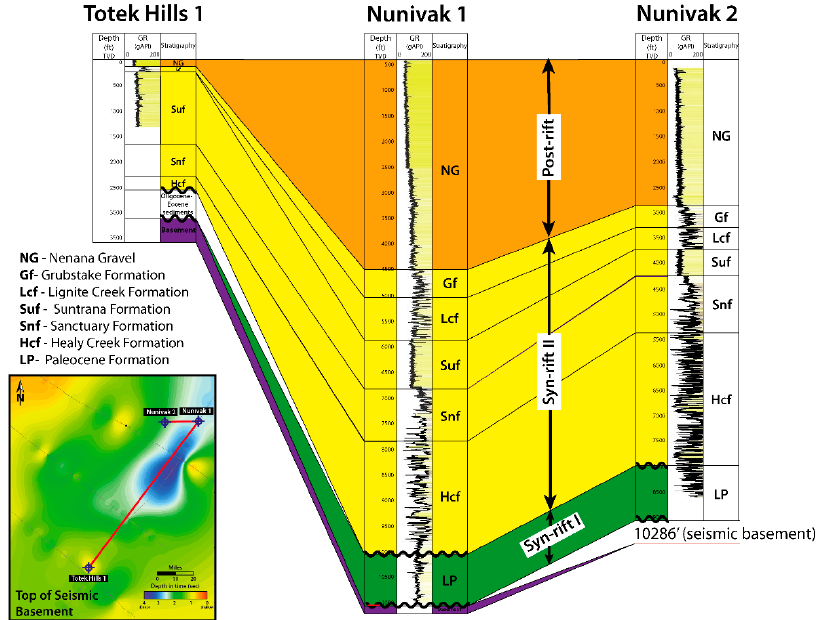
Figure 4. Lithostratigraphic correlation of exploration wells showing the subsurface depths and thickness variations of sedimentary sequences in the southern part of the Nenana basin [19,29,33]. Formation ages are based on palynomorphs data (G. Van Kooten, written communication, 2016).